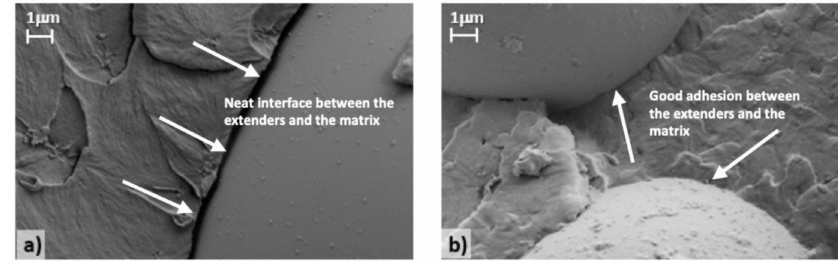
Figure 5. High-magnification SEM images of samples ( a ) 2 and ( b )